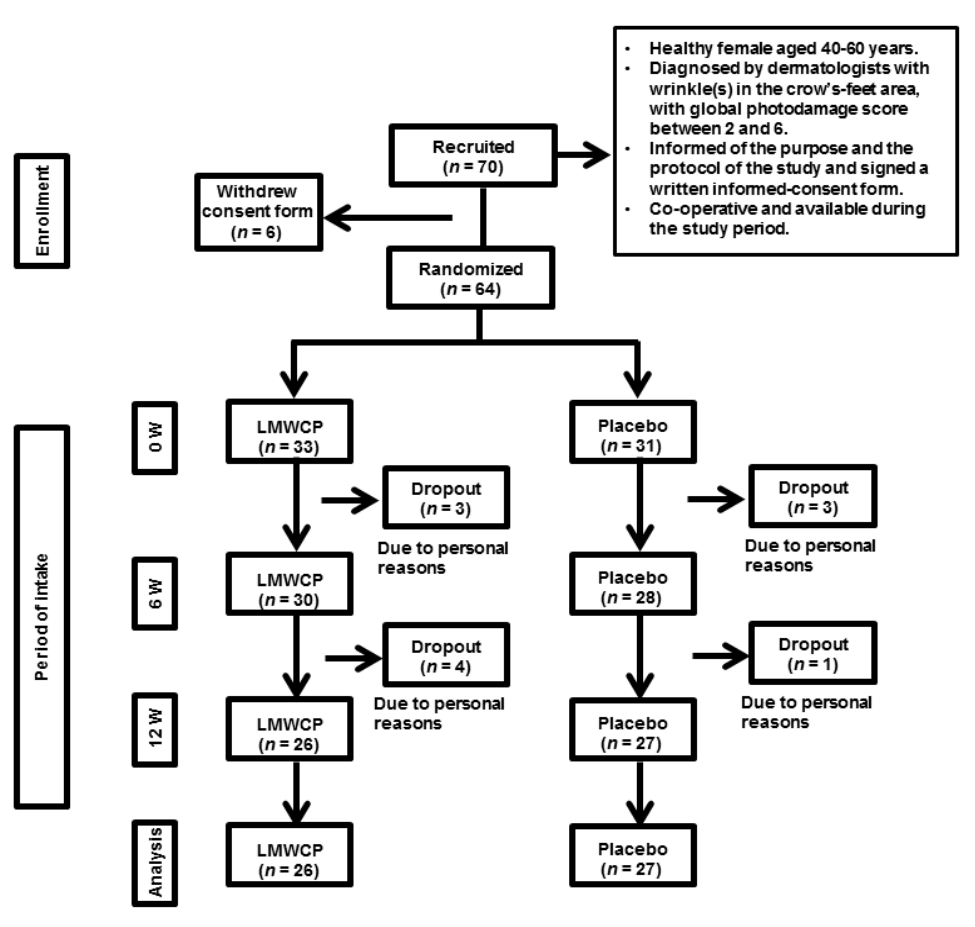
Figure 1. The study flow diagram. Abbreviations: LMWCP, Low-molecular-weight Collagen peptide; W, weeks.